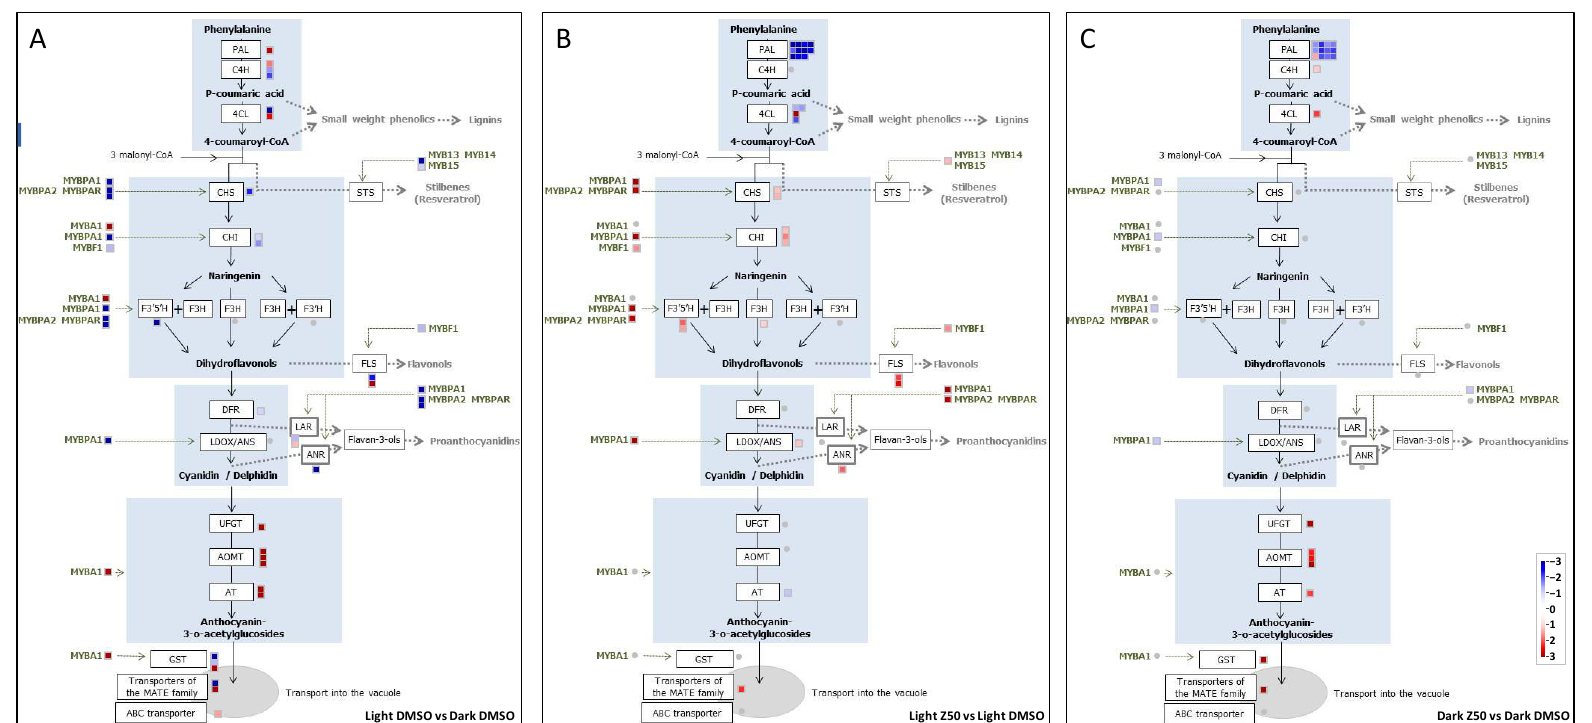
Figure 8. MAPMAN schematic representation of the anthocyanin biosynthesis pathway enlightening genes which were differentially expressed (|log2 FC| > 1, and padj > 0.05) ( A ) in the DMSO-treated light grown cells compared to the DMSO-treated dark grown cells, ( B ) in the zebularine-treated light grown cells compared to the DMSO-treated light grown cells, and ( C ) in the zebularine-treated dark grown cells compared to the DMSO-treated dark grown cells. ( A ) Red squares stand for genes up-regulated in light grown cells compared to dark grown cells and blue squares for genes down-regulated in light grown cells compared to dark grown cells. ( B , C ) Red squares stand for genes up-regulated in the presence of zebularine and blue squares for genes down-regulated by zebularine. The color intensity is proportional to the log2 FC as indicated in the upper left corners. The results obtained for the STS genes were not included since no specific behavior could be associated to this very large group of genes. Up-regulated genes in ( A ): PAL: Vitvi13g00622; C4H: Vitvi06g00803; 4CL: Vitvi06g01318; MYBA1: Vitvi02g01019; FLS: Vitvi18g02541; LAR: Vitvi17g00371; UFGT: Vitvi16g00156; AOMT: Vitvi01g01635, Vitvi01g02263, Vitvi01g02265; AT: Vitvi03g01816, Vitvi03g00077, GST: Vitvi04g00880; MATE transporter: Vitvi16g01913; ABC transporter: Vitvi16g01210; Down-regulated genes genes in ( A ): C4H: Vitvi11g01045; Vitvi11g00924; 4CL: Vitvi02g00938; MYB14: Vitvi07g00598; MYB15: Vitvi05g01733; MYBPA1: Vitvi15g00938; MYBPA2: Vitvi11g00099; MYBPAR: Vitvi11g00097; CHS: Vitvi14g01449; CHI: Vitvi13g01911; Vitvi04g00175; MYBF1: Vitvi07g00393; F3’5’H: Vitvi08g01637; FLS: Vitvi18g02538; DFR: Vitvi18g00988; LAR: Vitvi01g00234; ANR: Vitvi10g02185; GST: Vitvi19g01328; Vitvi19g01338; MATE transporter: Vitvi16g01911; Up-regulated genes in ( B ): 4CL: Vitvi02g00938; CHS: